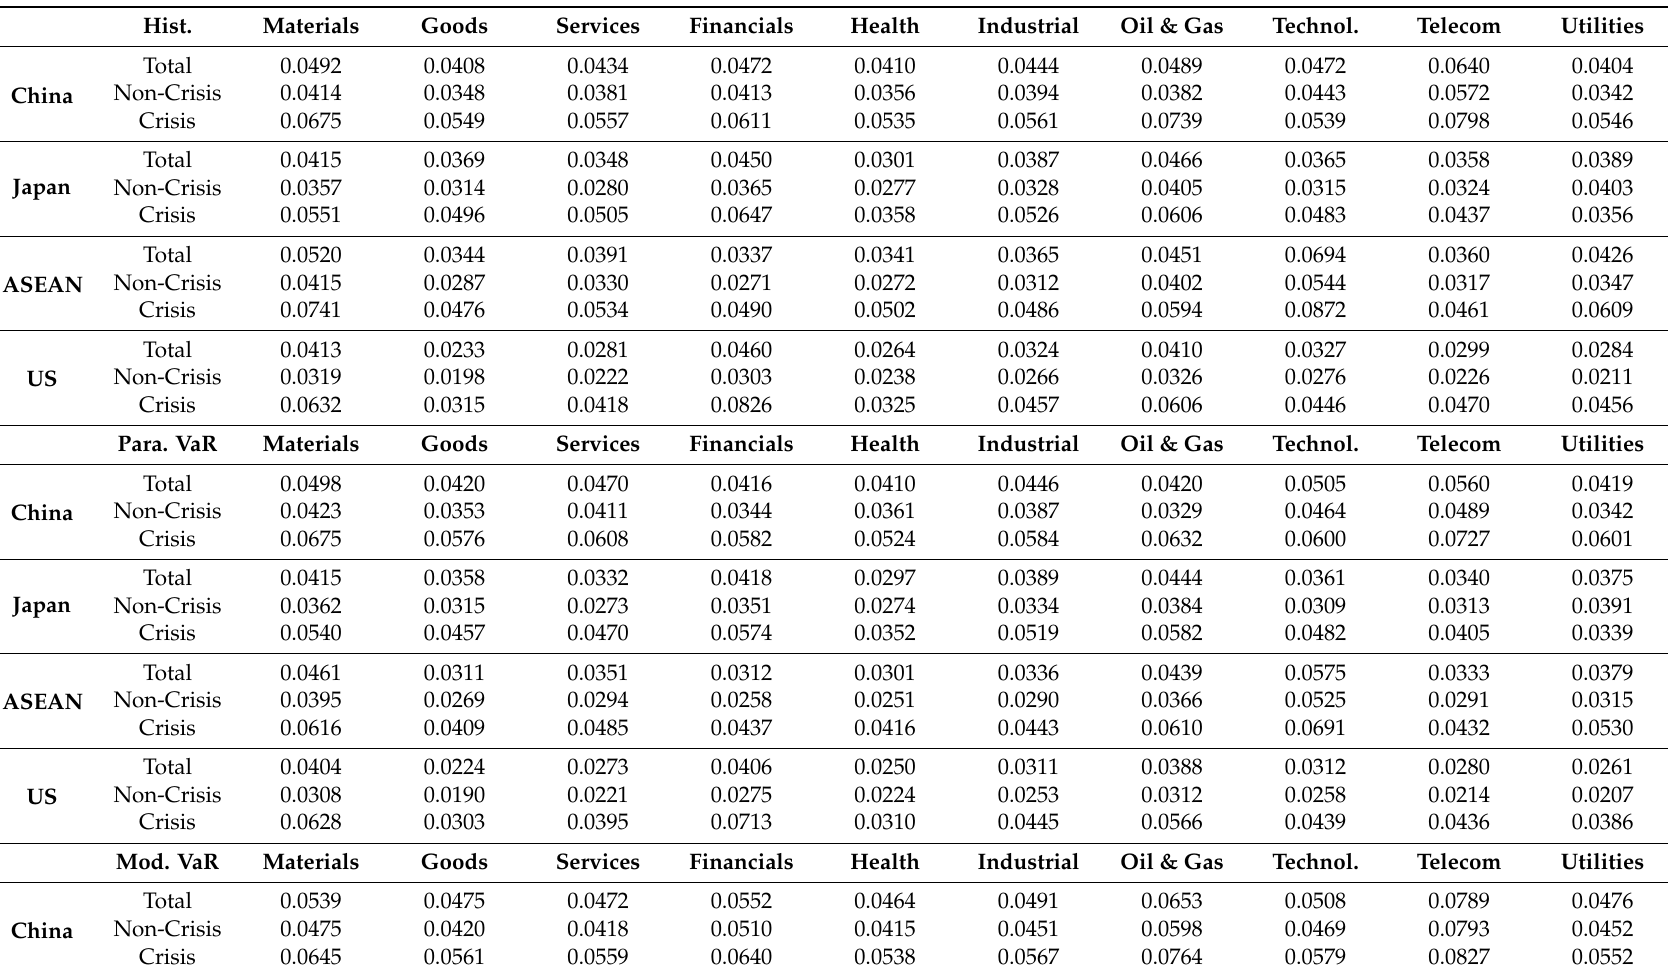
Table A2. 99% VaR and CVaR per industry: